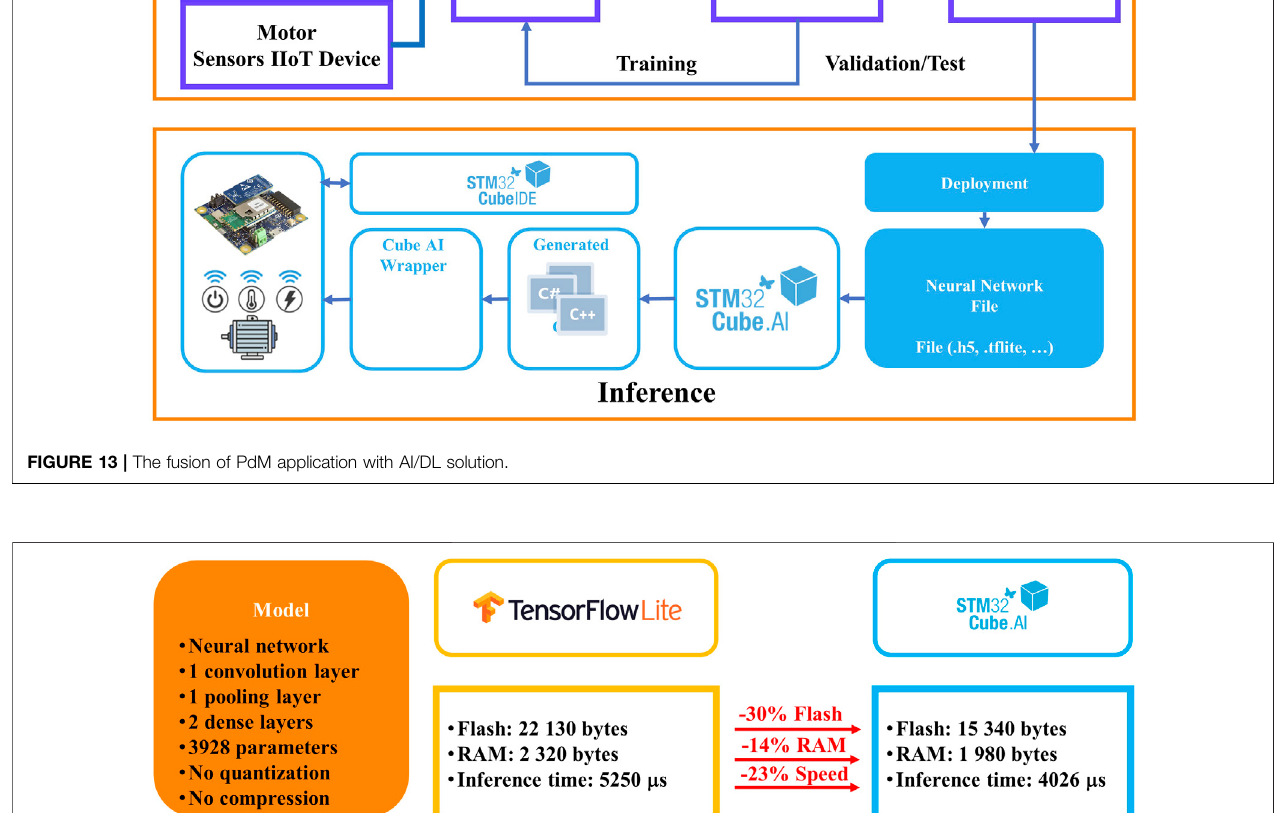
Frontiers in Chemical Engineering |